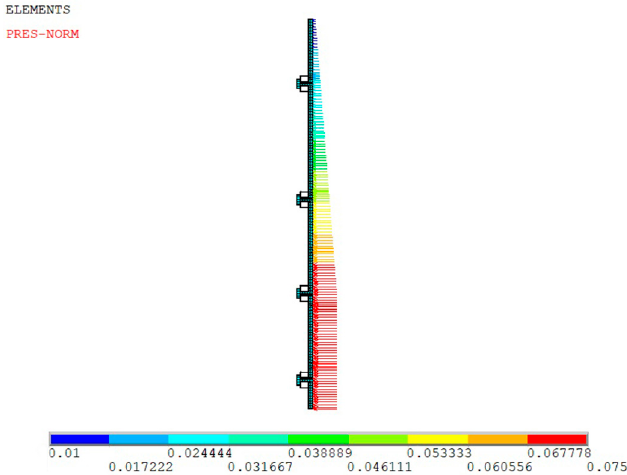
Figure 10. Lateral pressure on formwork.